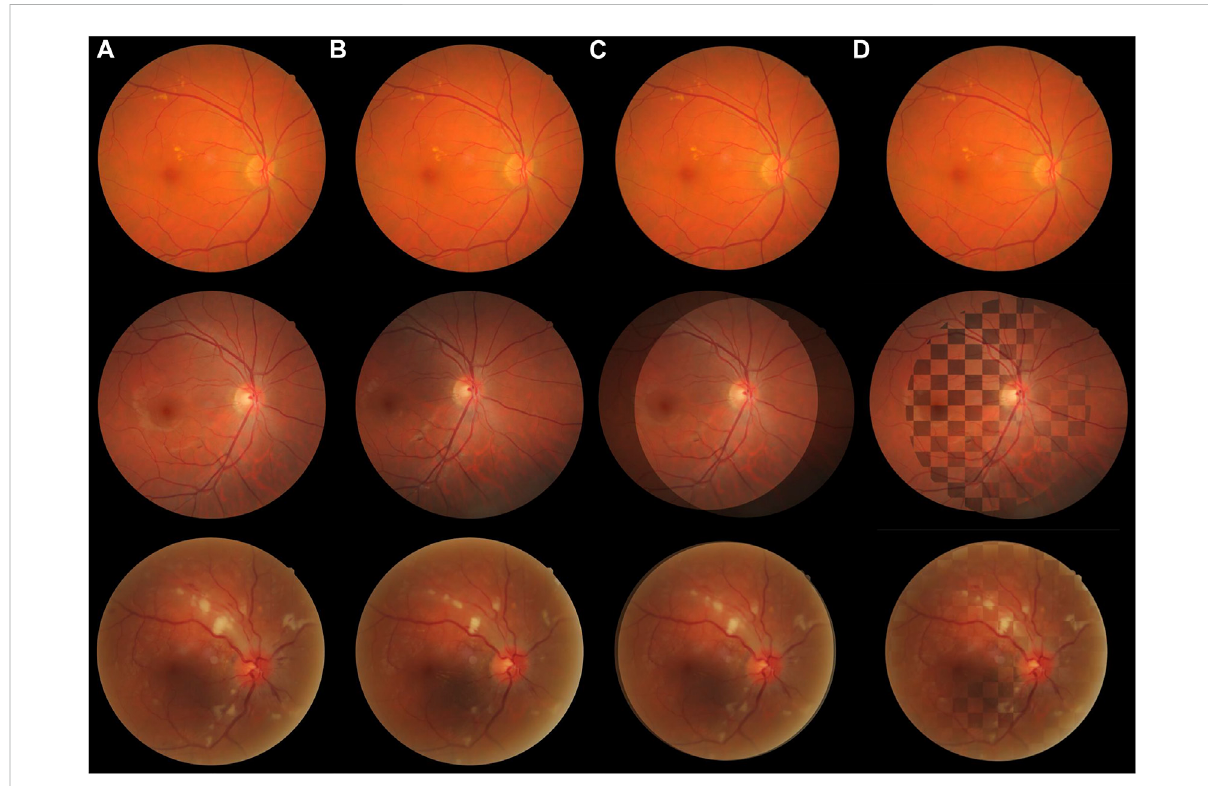
FIGURE 3 RegistrationresultsoftheproposedalgorithmintheFIREdataset.Theoverlapdecreasesfromthetoprowtobottom. (A) and (B) areimagepairs without registration. (C) Image pairs shown in an overlaying form after registration. (D) Checkerboard comparisons of the proposed method.